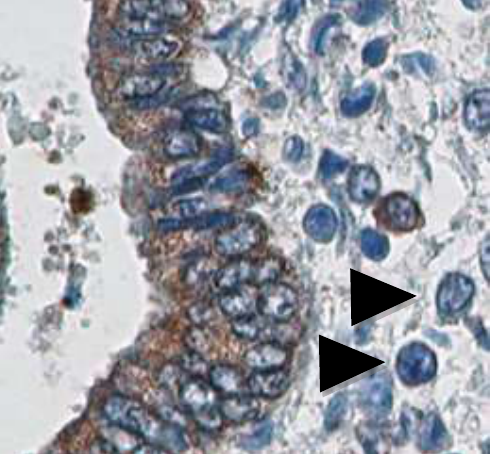
Figure 1. Effectiveness of IHC-CD138 for identification of ESPCs. Light microscopic image of human endometrium with IHC-CD138 and hematoxylin nuclear staining. The tissue contains several cells with spoke-wheel/clock-face patterns (arrows) but is negative for CD138, which is difficult to distinguish via conventional tissue staining alone. Reprinted from Kitaya et al., Current understanding of chronic endometritis. Diagnostic. Histopathol. 2013, 19, 231–237 (Copyright Clearance Center Number 5407080987200, RightsLink/Elsevier). Table 1. Predominance of endometrial stromal CD138( − ) cells with spoke-wheel/clock-face ap- pearance over endometrial stromal CD138(+) cells with the same appearance in CE. A total of 1568 endometrial stromal cells were evaluated in the archival photographs ( × 400 magnifications) of the endometrial IHC-CD138/hematoxylin-eosin-stained sections of seven CE cases ( p < 0.0001 according to Fischer’s exact